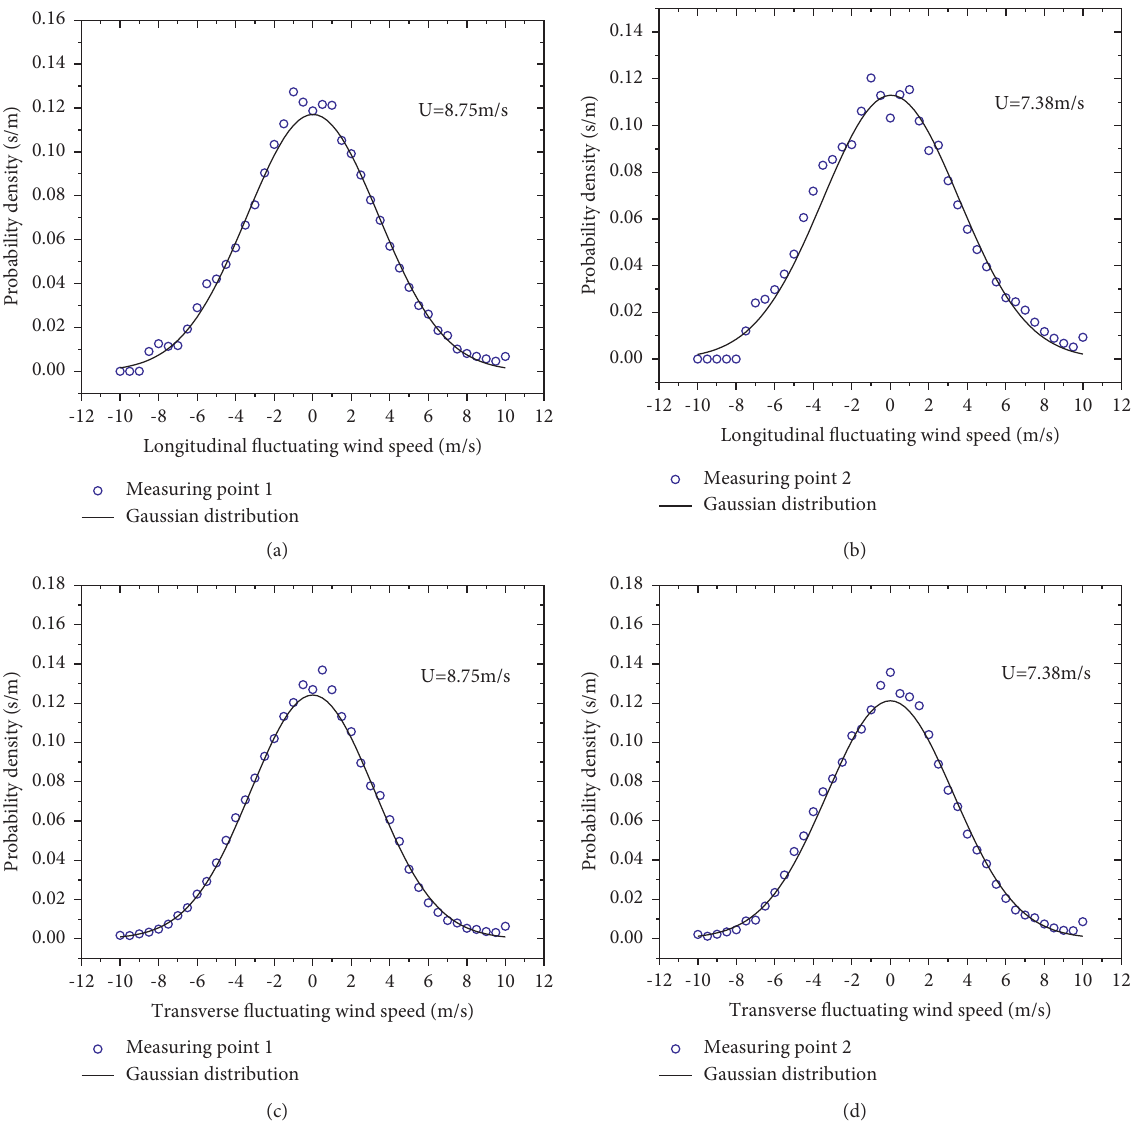
Figure 4: Probability density distribution of fluctuating wind speed. (a) Probability density of longitudinal fluctuating wind speed at point 1. (b) Probability density of longitudinal fluctuating wind speed at point 2. (c) Probability density of transverse fluctuating wind speed at point 1. (d) Probability density of transverse fluctuating wind speed at point